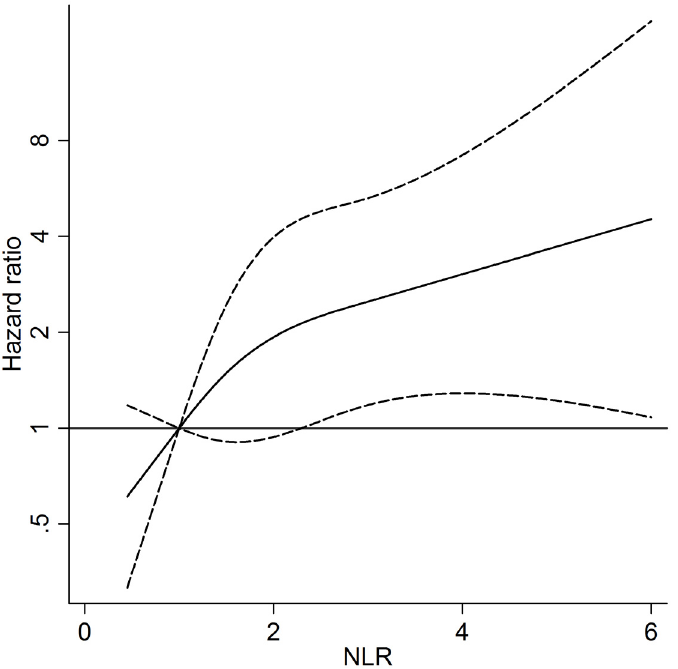
diabetes and tobacco smoking as fixed covariates, and CD4 cell count, antiretroviral therapy, presence of hypertension, SBP, total cholesterol and HDL as time dependent covariates. The reference value is 1.2. The 95% confidence intervals are shown as dashed lines. Vertical axes have a logarithmic scale . Abbreviations: NLR, neutrophil to lymphocyte ratio; SBP, systolic blood pressure; HDL, high density lipoprotein.